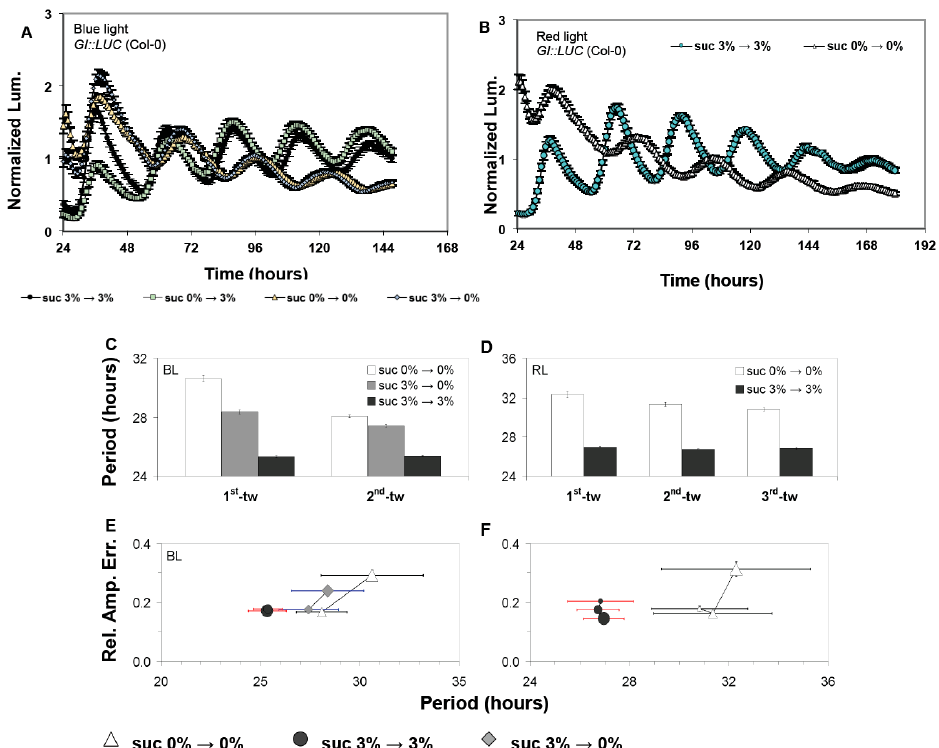
Figure 1. The effect of sucrose on rhythmic expression of the luciferase marker GI::LUC . The free-running period of GI::LUC seedlings (Col-0) under either monochromatic blue light (BL) ( A , C , E ) or red light (RL) ( B , D , F ). Panels (A,B) shows the time-course of average luminescence from representative experiments, while panels (C–F) show combined data from the independent experiments conducted as described above (six experiments under BL and three under RL). Under RL fast Fourier transform (FFT) analysis was performed during the time windows 06–101 h (1st-tw), 31–126 h (2nd-tw), and 56–151 h (3rd-tw) (beginning of free run was initiated at 0 h, as indicated in the figures). Under BL, FFT analysis was performed during the time windows 06–96 h (1st-tw) and 31–121 h (2nd-tw). Error bars represent standard error (SE). In (E) BL and (F) RL, the relative amplitude error (RAE) and circadian period are paired for all plants that generated an FFT output (RAE < 0.9; see Methods section); in these graphs, the closer a population is to the origin, the more robustly it